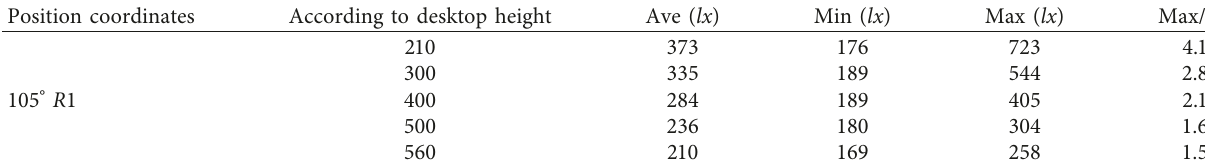
Table 3: Illumination information of working face.